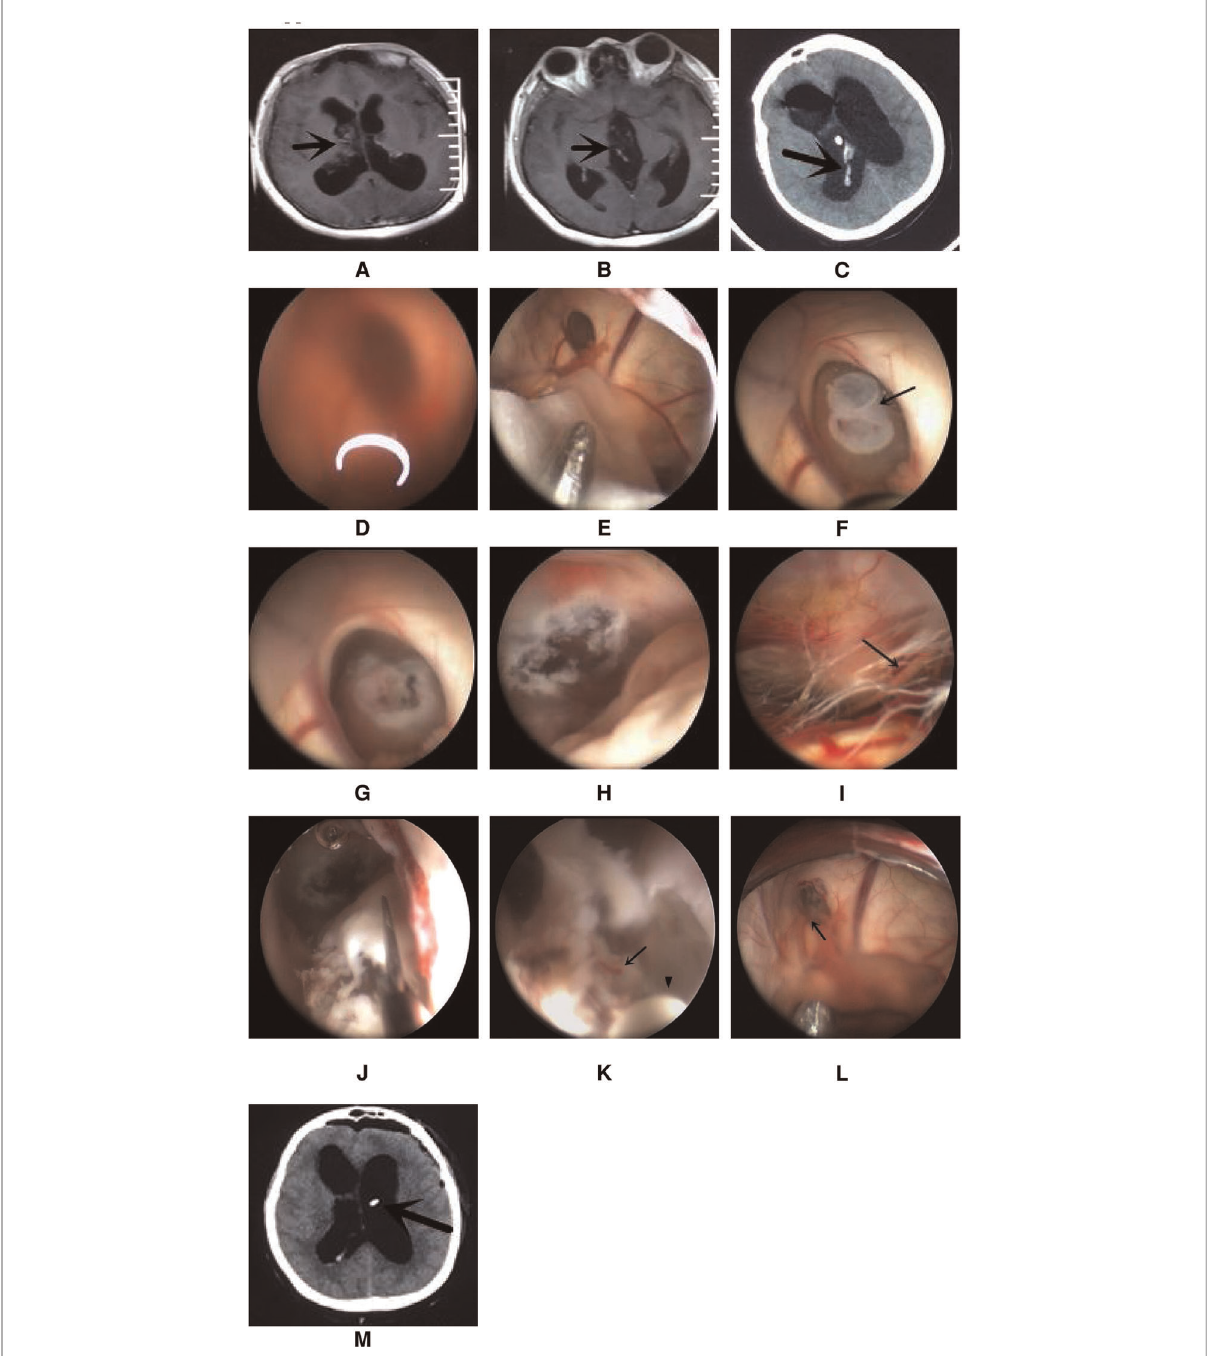
FIGURE 4 Endoscopic intraventricular surgery was used to perform biopsy and ETV in case 8. ( A,B ) show MRI scans of the lesion in the right lateral ventricle and third ventricle. ( C ) CT scan showing a hemorrhage in the ventricle after EVD. ( D ) Surgical image through the left ventricle showing a blurred image due to a bloody CSF. ( E ) The extra-endoscopic technique was used to clean the image through a slim pledget and suction. ( F ) The lesion was seen to block the foramen of Monro. ( G ) The intra-endoscopic technique was used to coagulate and shrink the tumor. ( H ) Image showing successful ETV with an ori fi ce of more than 5 mm. ( I ) Image showing the prepontine cistern; the arrow shows the abducent nerve. ( J ) The tumor was removed by scissors after ETV. ( K ) Bleeding (arrow point) from a small artery during continuous irrigation at the course of coagulation of concentric circle bipolar (indicated by the arrowhead). ( L ) The source of bleeding (arrow point) was located to a vein close to the foramen of Monro and was stopped by the application of the extra-endoscopic technique. ( M ) CT scan on day 1 after ETV; the arrow shows the Ommaya